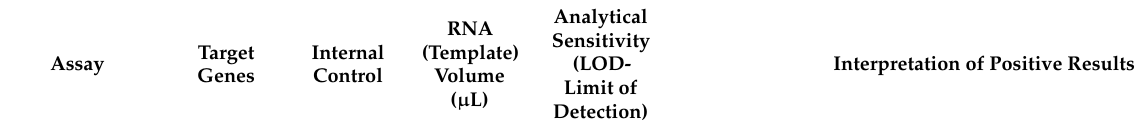
Table 1. Overview of molecular kits used in this study and rules of